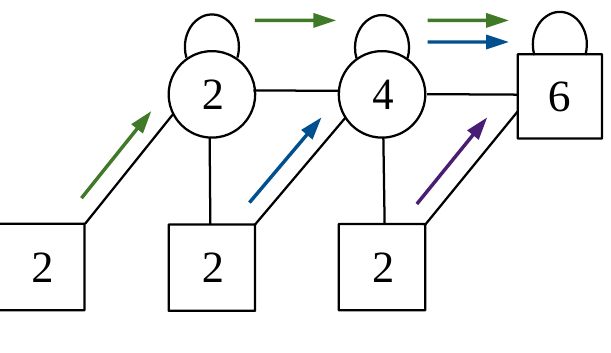
Figure 6: Operators contributing to Π in the Q = 3